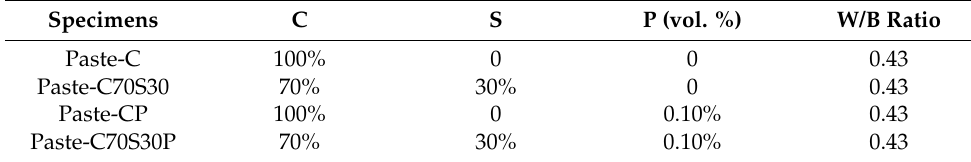
Table 3. The mix ratio of CBRM-Mortar.